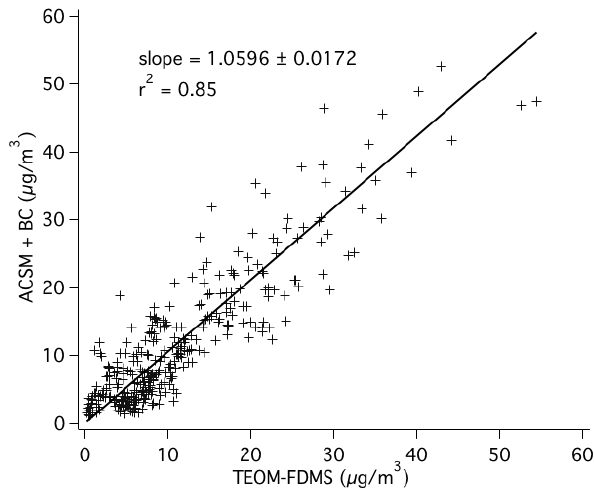
Figure 3. Mass closure exercise between daily averaged recon- structed PM 1 (ACSM + BC) and measured PM 1 by